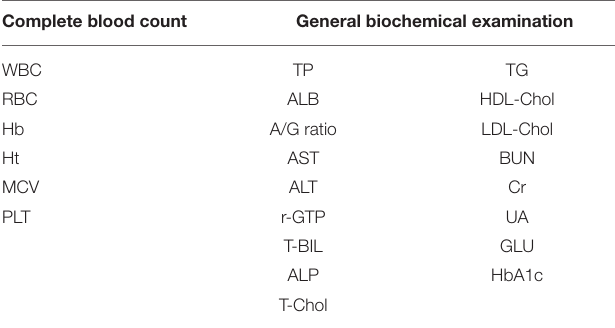
TABLE 2 | Mean values and ranges of blood test